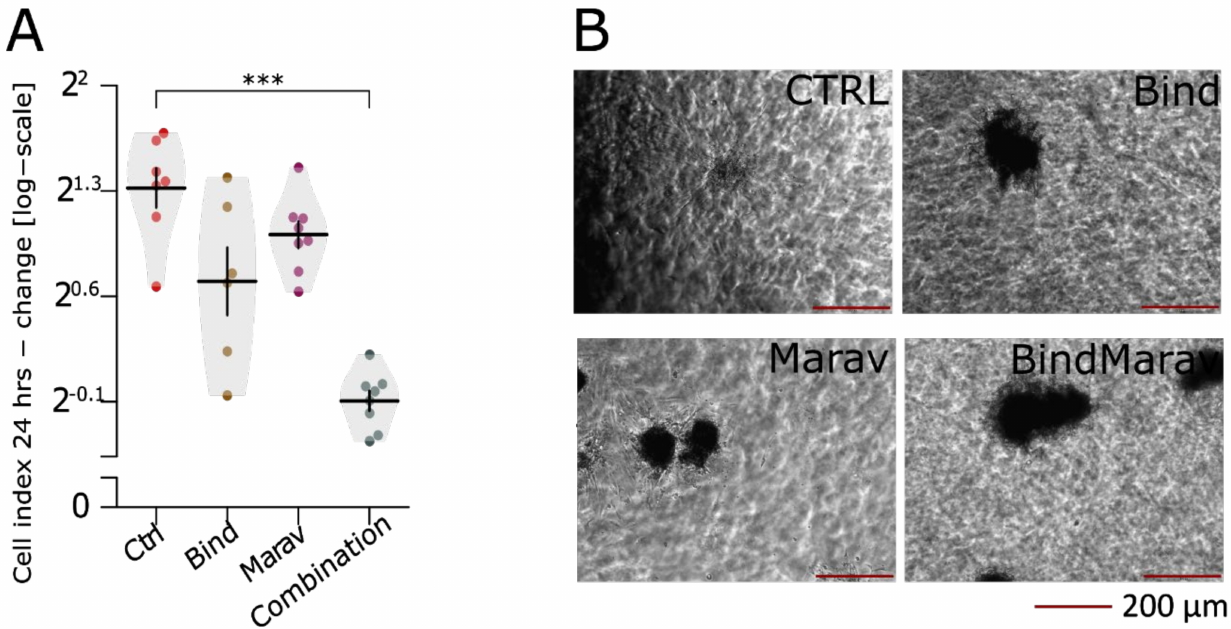
Figure 8. Pharmacological inhibition of Ccl8 - Ccr5 signalling entails a significant decline in invasive capacity. Cells were treated with Bindarit (Ccl8 inhibitor, 250 µ M), Maraviroc (Ccr5 inhibitor, 10 µ M), or their combination and their invasiveness was analysed by xCelligence motility assay ( A ) and by the invasion of multicell tumour spheroids of JUN-sarcoma cell lines embedded into type I collagen identically to or. ( B ) Linear model revealed that both Bindarit (SS = − 0.89 (95% CI: − 1.15, − 0.69), p < 0.001) and Maraviroc (SS = − 0.54 ( − 0.82, − 0.26), p < 0.001) significantly decreased the motility of JUN-3 cells, but we were not able to detect significant effect of their interaction (SS = − 0.48 ( − 1.04, 0.08), p = 0.072). *** p < 0.001. The statistical significances are based on permutational t -test with FDR correction. See Table S8 for effect sizes, their confidence intervals, and exact p -values. Each point represents an individual well. Violin plots with means ± SEM are